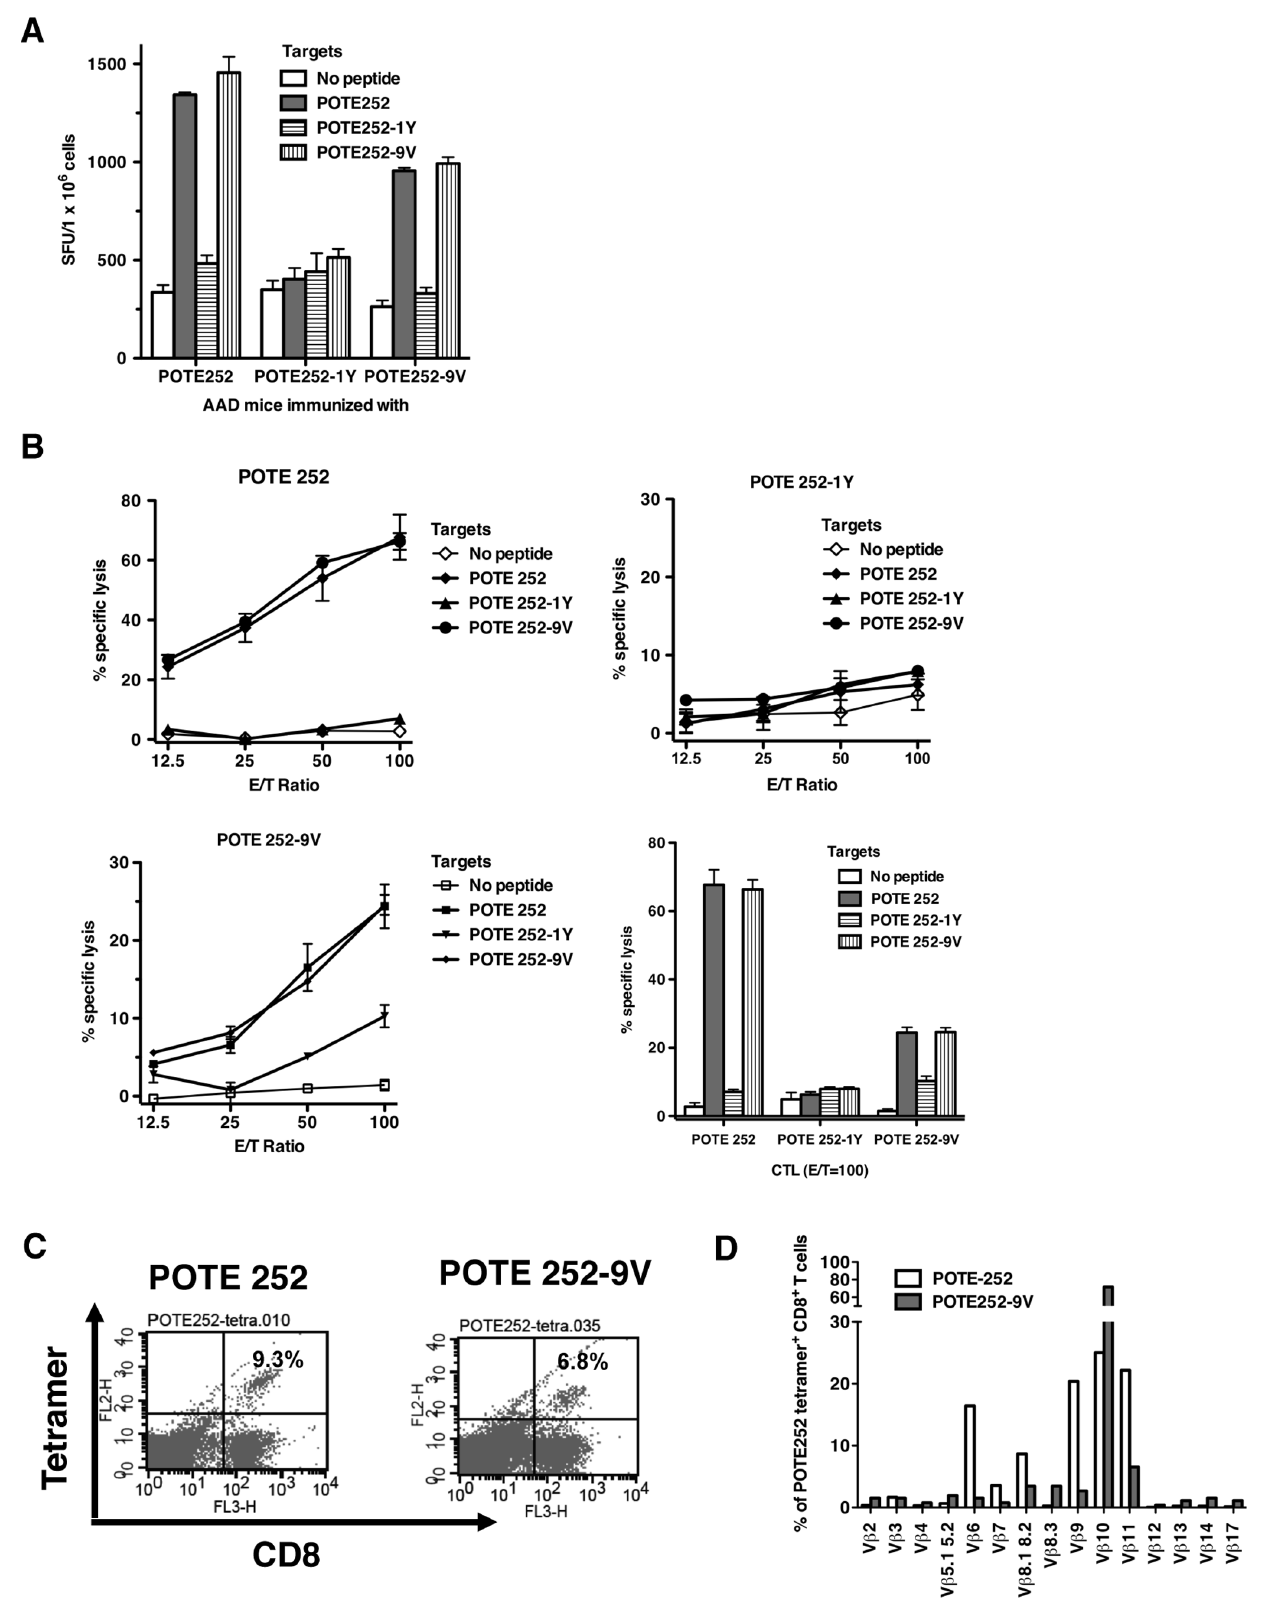
Figure 2. Immunogenicity of the wild type and enhanced POTE 252 epitopes in AAD mice. (A) Mice were immunized with 50 nmol of POTE 252 in 100 m l of emulsion, and targets were pulsed with 1.0 m M POTE252. Spots were counted by an ELISPOT reader (AID ELISPOT reader